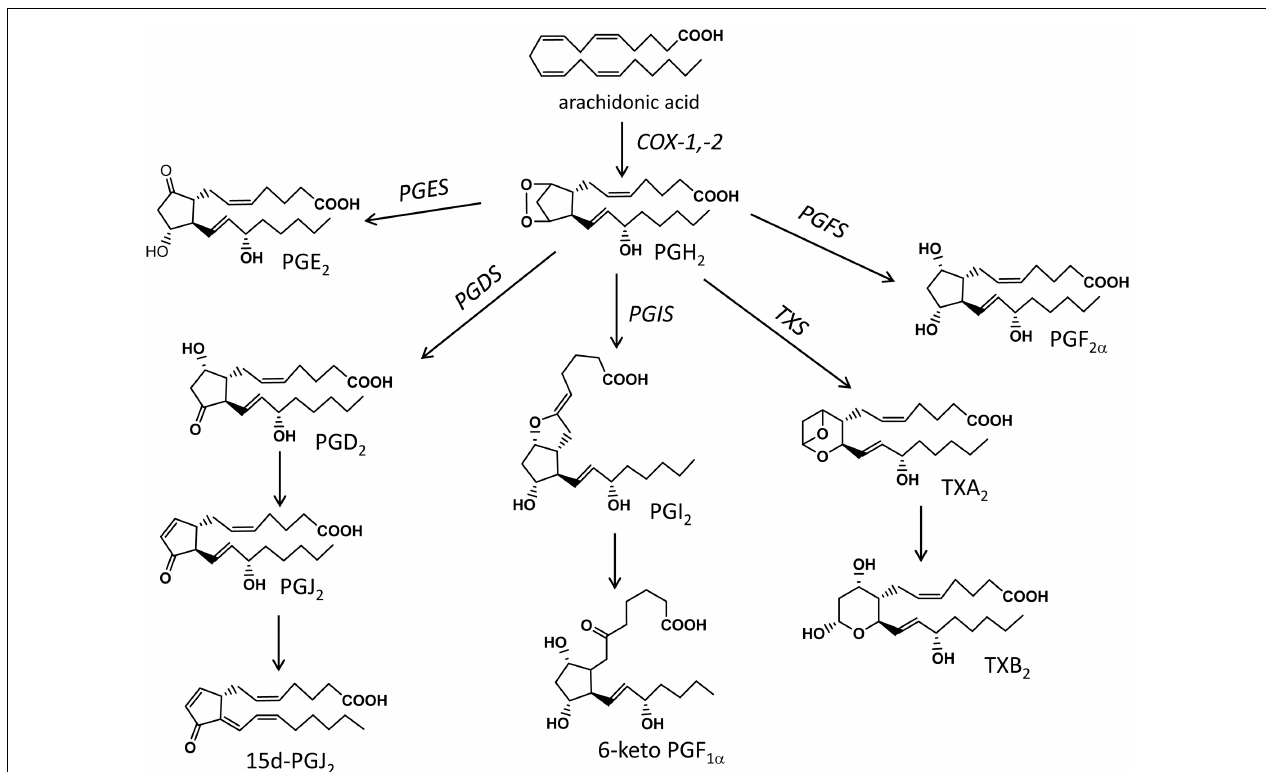
FIGURE 1 | Schematic representation of the main biochemical pathways that mediate the production of prostanoids . COX, cyclooxygenase; PGES, prostaglandin E synthase; PGDS, prostaglandin D synthase; PGFS, prostaglandin F synthase; PGIS, prostacyclin synthase;TXS, thromboxane synthase.